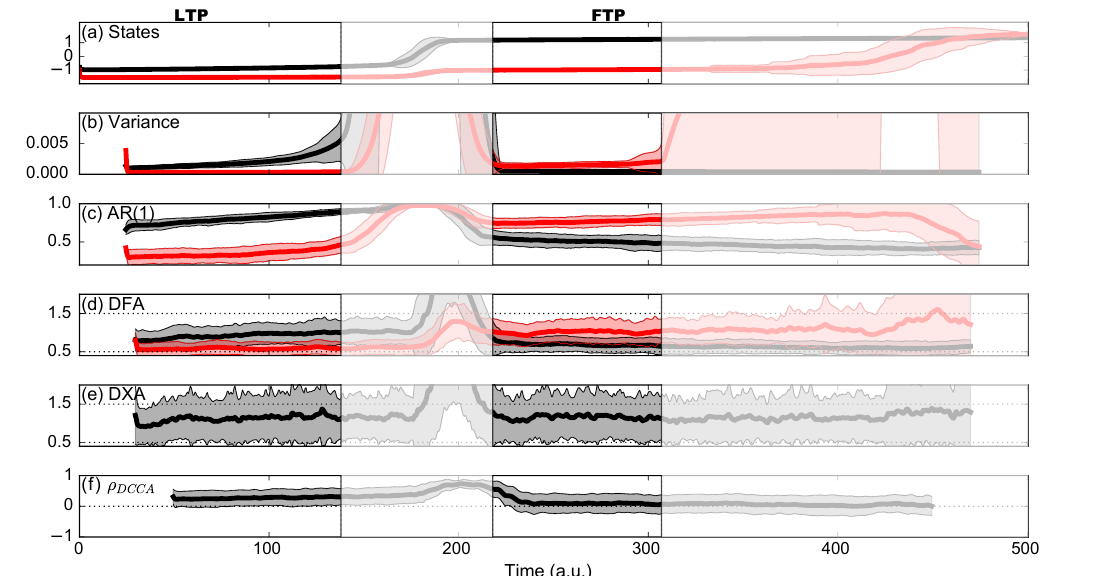
Figure 3. Ensemble (100-member) simulations of a dynamical system undergoing a double-fold cascade (Eq. 13) where both systems undergo a transition, parameter values as in Table 2; (a) states of x (black) and y (red), (b) variance of x (black) and y (red), (c) auto- regressive coefficient at lag 1 of x (black) and y (red), (d) detrended fluctuation analysis scaling exponent of x (black) and y (red), (e) detrended cross-correlation analysis scaling exponent and (f) detrended cross-correlation coefficient by Zebende (2011). White-shaded areas indicate windows containing the actual transitions. The increased variance, AR(1) and the DFA scaling exponent prior to transition in the respective leading system and following system, confirms the predicted increased memory through critical slowing